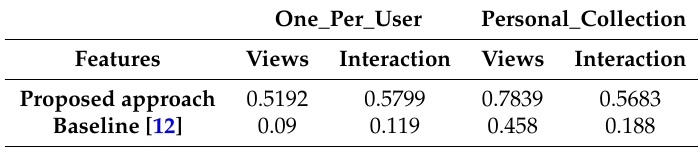
Table 11. Comparison of our proposed approach to Baseline